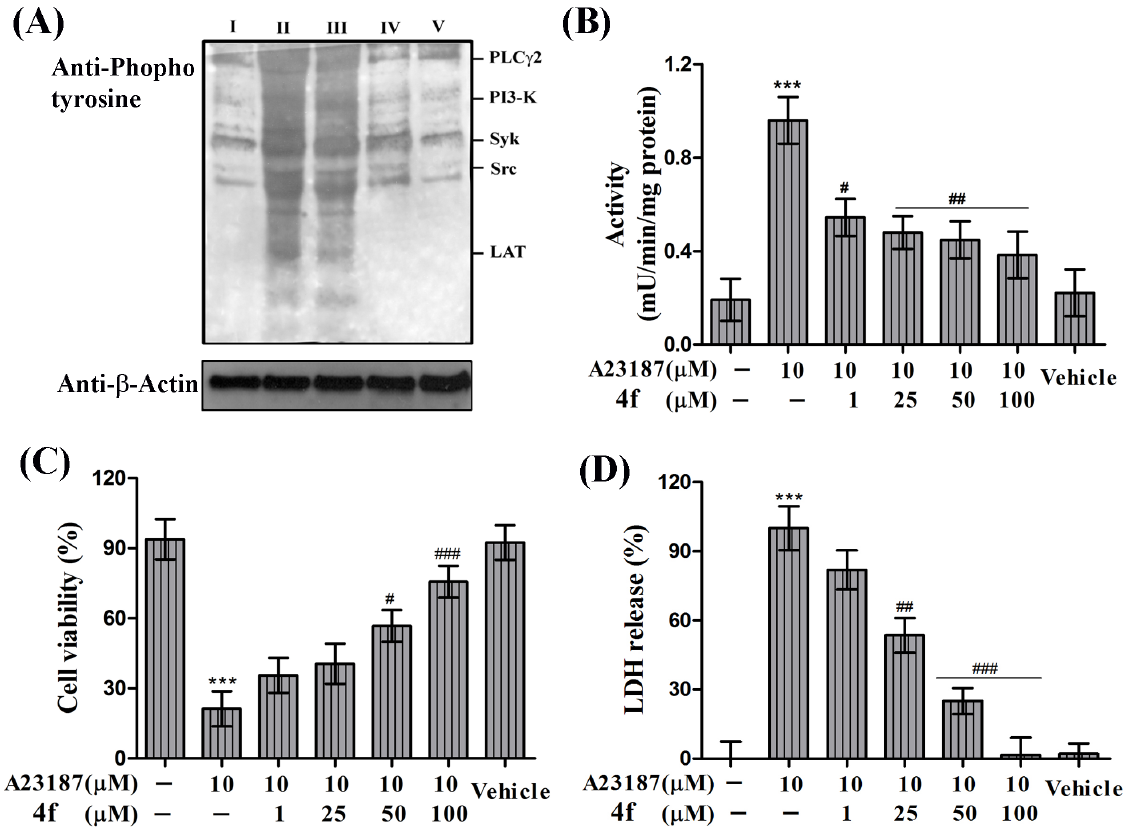
Figure 5. Effect of compound 4f on (A) Collagen induced protein phosphorylation (B) A23187 induced c - glutamyltransferase activity (C) MTT cell viability assay (D) LDH release in platelets. (A) Lane I- resting platelets (untreated). Lane II- platelets treated with Collagen (1 m g/mL). Lanes III, IV and V- pre-loaded platelets with collagen and incubated with 4f in increasing concentration of 25, 50 and 100 m M respectively. Values are presented as mean 6 SEM (n=5). *** p , 0.001; significant compared to control. # p , 0.05, ## p , 0.01, ### p , 0.001; significant compared to agonist.